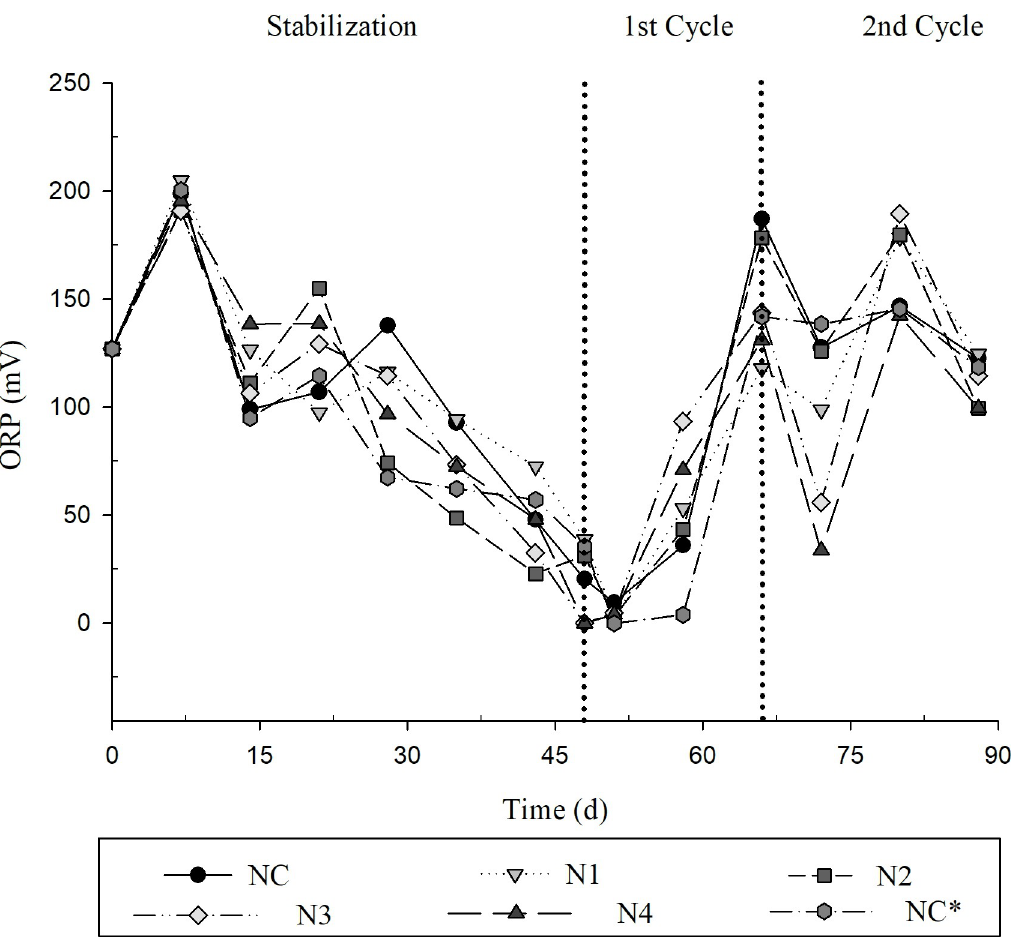
Fig 8. Oxidation-reduction Potential of sanitary effluent treated for the different treatments. NC = 0; N1 = 5; N2 = 25; N3 = 50 and N4 = 100 μ M GA 3 ; NC � control without the cultivation of Tifton 85 bermudagrass.